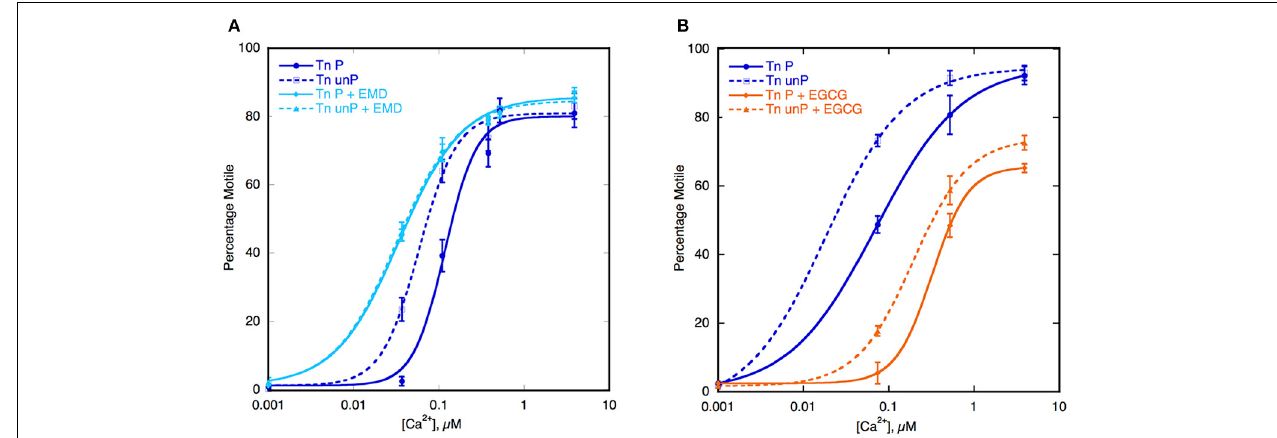
FIGURE 4 | Effect of Ca 2 + -sensitizers and desensitizers on coupling in thin filaments. Thin filament motility was measured by motility assay over a range of [Ca 2 + ] in paired cells. The percentage of filaments motile is plotted as a function of [Ca 2 + ] for representative experiments. Solid lines and points, phosphorylated thin filaments, dotted line and open points, unphosphorylated thin filaments (obtained by phosphatase treatment). The points ± s.e.m. are the mean of four determinations of percentage motile